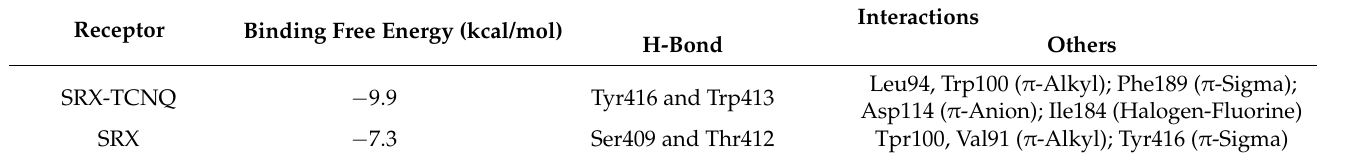
Table 3. The interactions of SRX-TCNQ and SRX with dopamine (6CM4).